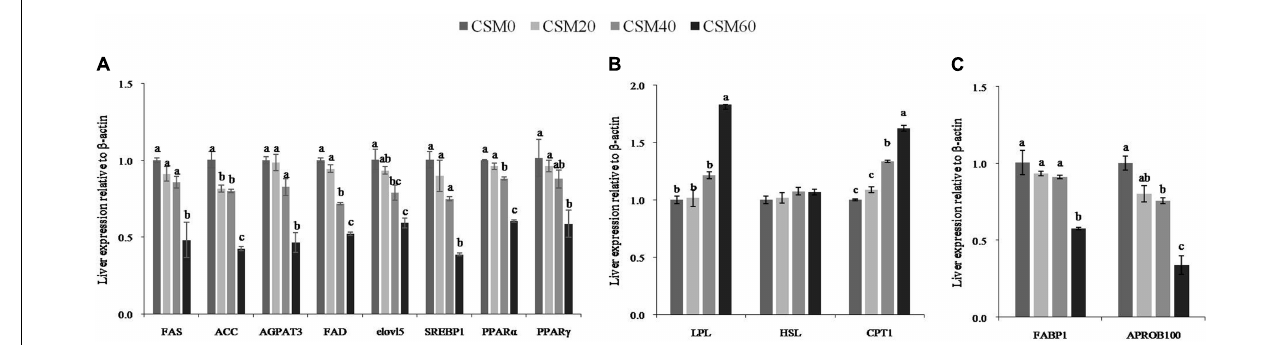
FIGURE 2 | Diagrammatic representation of the gene expression pattern of the key transcripts involved in lipid metabolism after juvenile golden pompano ( Trachinotus ovatus ) fed with CSM0, CSM20, CSM40, and CSM60 diets, respectively. (A) Lipid anabolism. (B) Lipid catamolism. (C) Lipid transporters. Values with different superscripted small letters mean significant difference ( P < 0.05). FAS, fatty acid synthetase; ACC, acetyl-CoA carboxylase; AGPAT3, 1-acylglycerol-3-phosphate acyltransferase 3; FAD, fatty acyl desaturase; elovl5, elongase of very long-chain fatty acids 5; SREBP1, sterol regulatory element